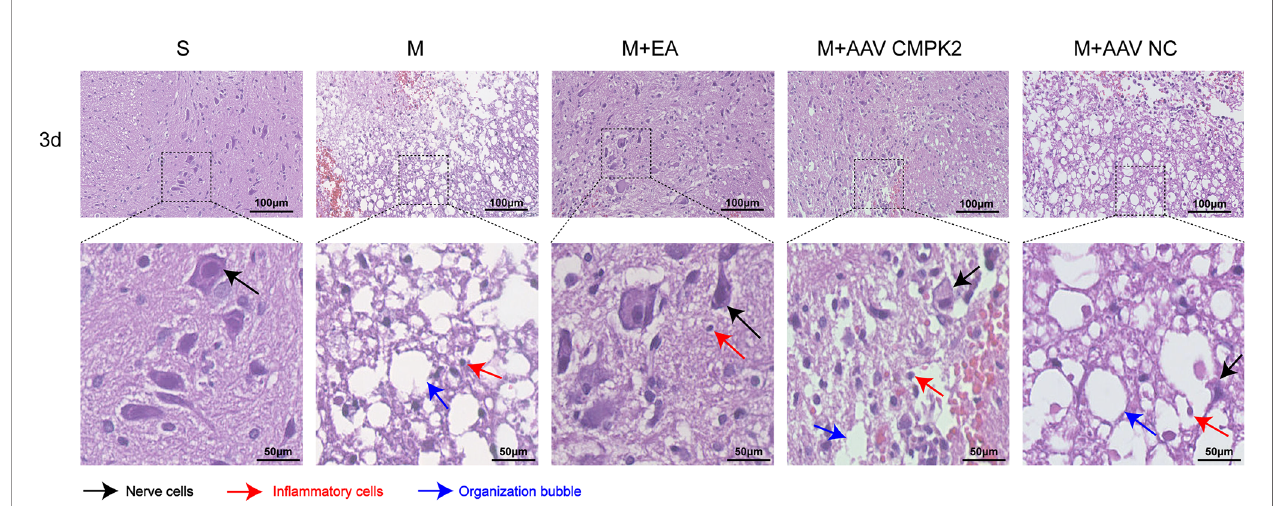
FIGURE 11 | Pathological examination results of H&E staining of rat spinal cord tissues in each group. Representative images show the spinal cord around the central canal 3 days after SCI in the sham, model, M+EA, M+AAV CMPK2, and M+AAV NC groups. The black arrows indicate nerve cells. The red arrows indicate in fl ammatory cells. Blue arrows indicate tissue vacuoles. N = 3 rats/group. SCI, spinal cord